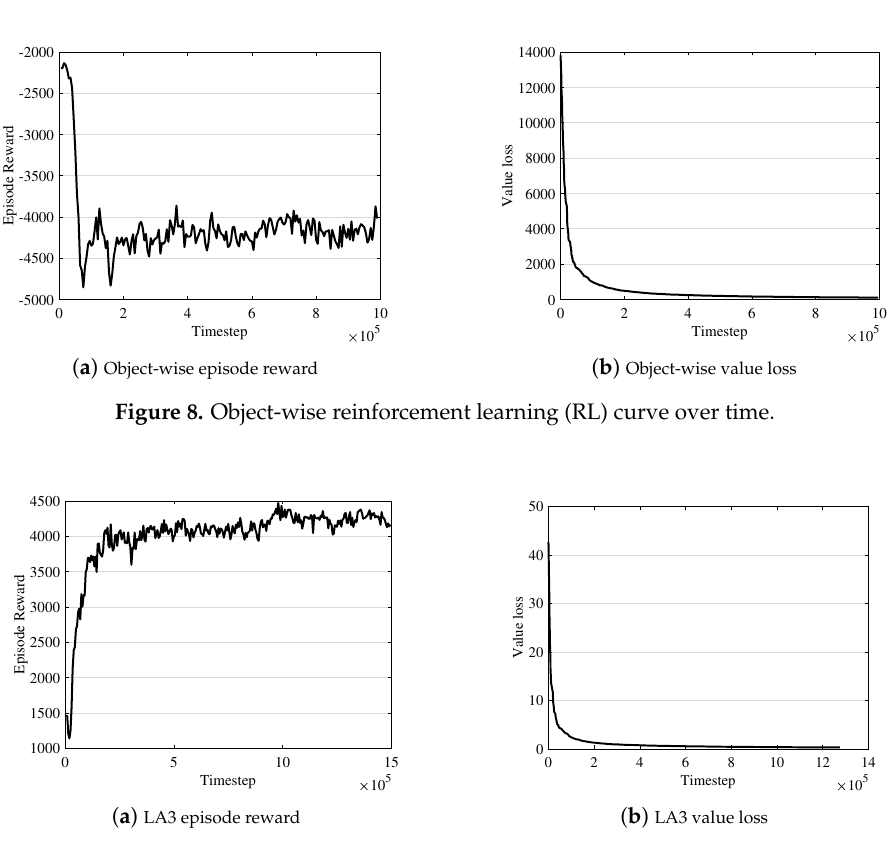
Figure 9. LA3 learning curve over